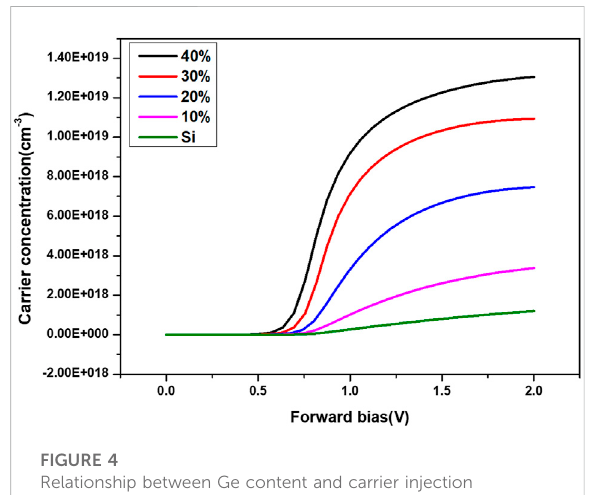
Relationship between Ge content and carrier injection